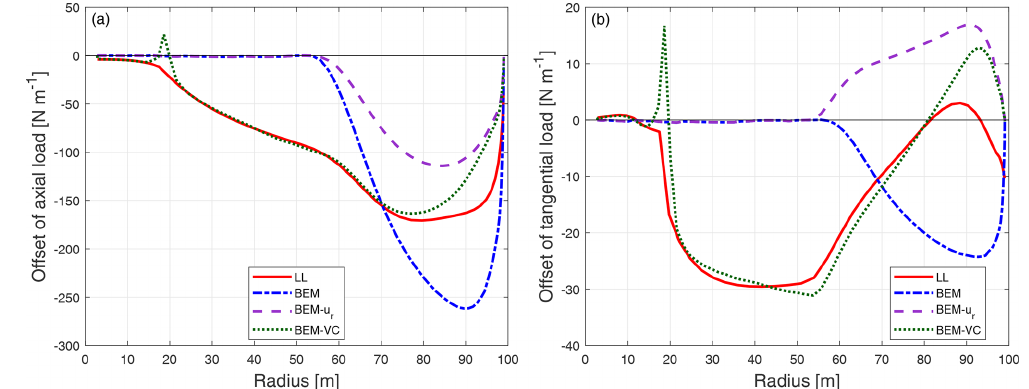
Figure 19. Comparison of the difference of the axial load (a) and tangential load (b) of the dihedral blade W-1-U12 compared to the baseline blade calculated from different models. The wind speed is 12ms − 1 , the tip-speed-ratio is 7.5 and the additional twist angle θ p is 5.98 ◦ .